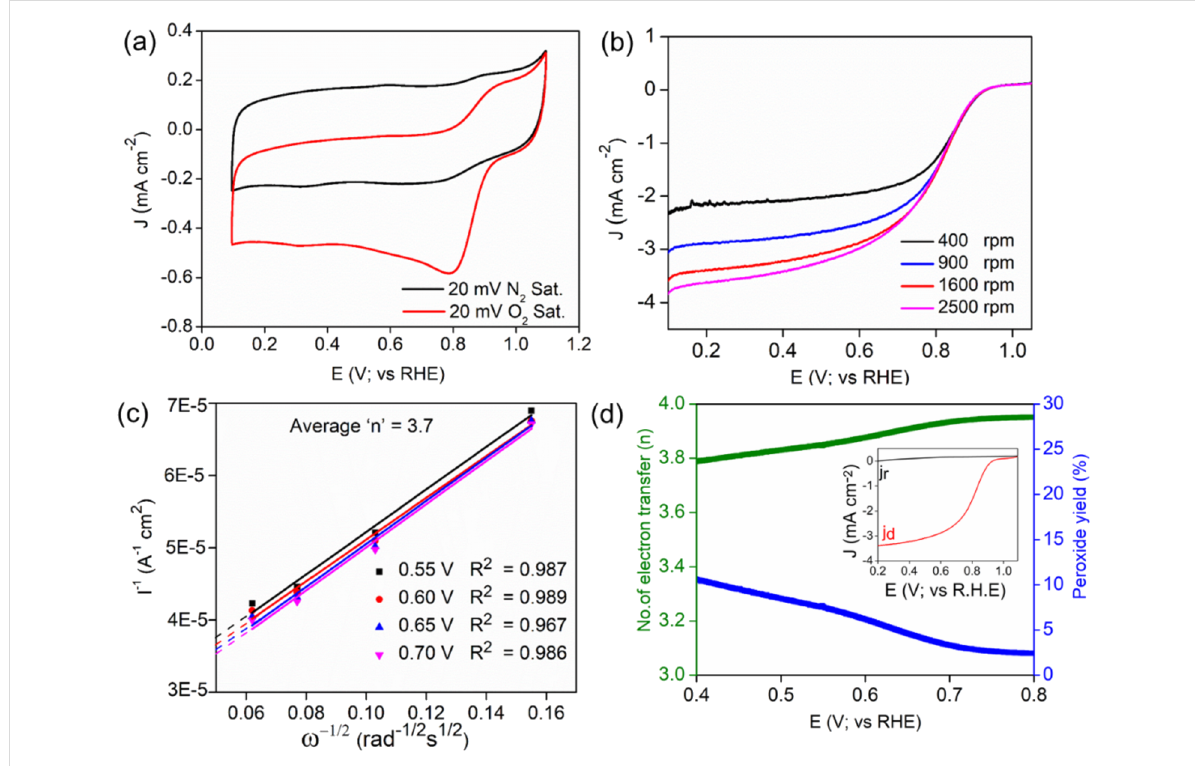
Figure 3: (a) Comparative CV profile of ACC-2 in N 2 - and O 2 -saturated 0.1 M KOH at a scan rate of 20 mV·s − 1 . (b) LSV curves of ACC-2 at different rotation speeds with a sweep rate of 10 mV·s − 1 . (c) Koutecky–Levich plot and (d) peroxide yield and n during ORR on ACC-2, the inset shows a RRDE voltammogram at a scan rate and rotation speed of 10 mV·s − 1 and 1600 rpm,